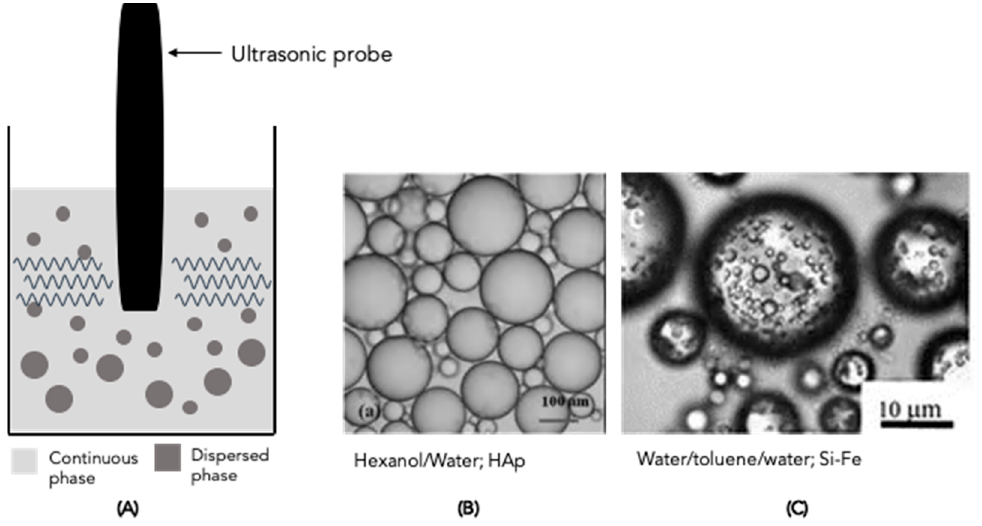
Figure 5. Schematisation of the ultrasonic device ( A ), and some examples of PEs (( B ) [143] and ( C ) [105]). (Reprinted from [143], Copyright (2019), with permission from Elsevier; Reprinted from [105], Copyright (2013), with permission from Taylor and Francis).